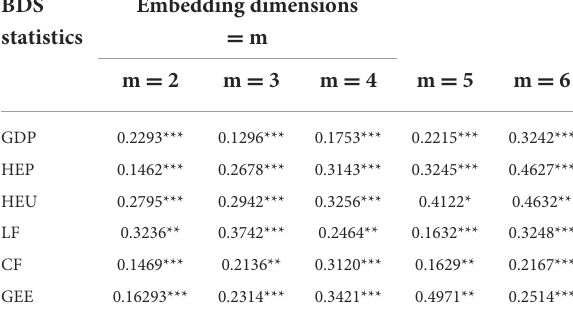
TABLE 3 BDS test for detecting nonlinear